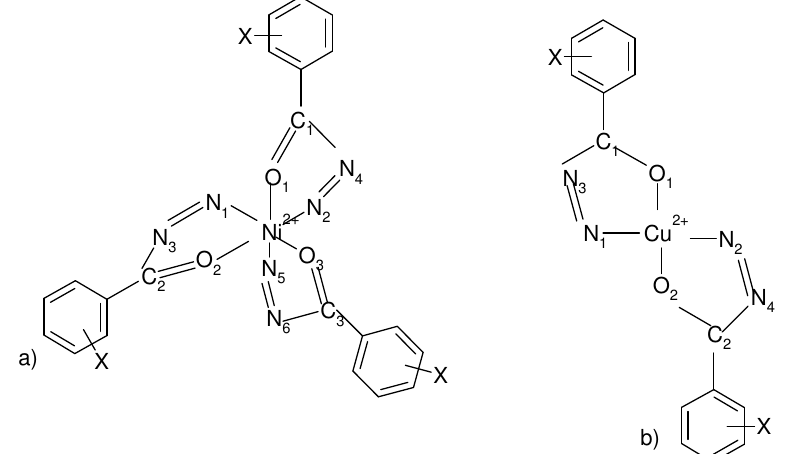
Figure 1. Sketch structures of M(II) benzoic acid hydrazides ions [a=Cupper(II), b=Nickel(II) and X = methyl or